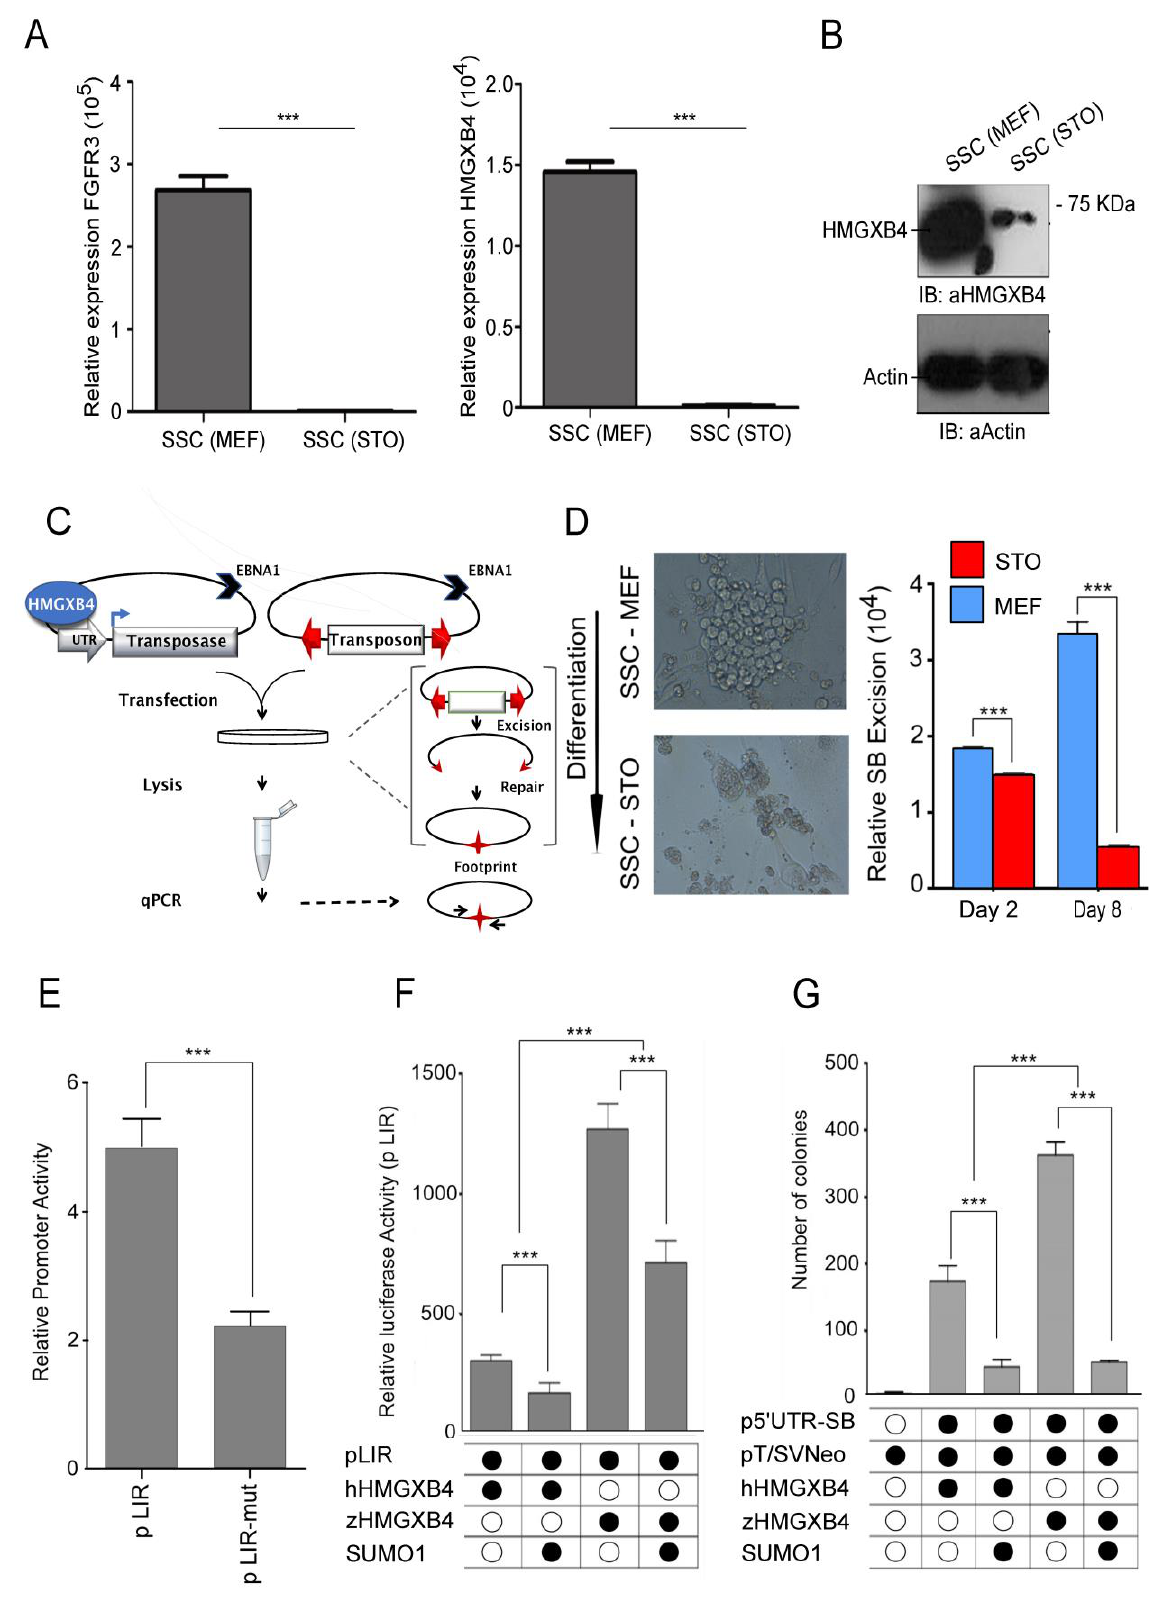
Figure 6. HMGXB4 Targets Sleeping Beauty Transposition to the Germline. ( A ) HMGXB4 transcription in spermatogonial stem cells (SSCs) declines upon differentiation (qRT-PCR). Relative expres- sion FGFR3 (left panel) and HMGXB4 (right panel) in rat SSCs cultured on either MEF or STO feeder cells (*** p < 0.01). ( B ) HMGXB4 protein level is reduced in rat SSCs when cultured on STO feeder